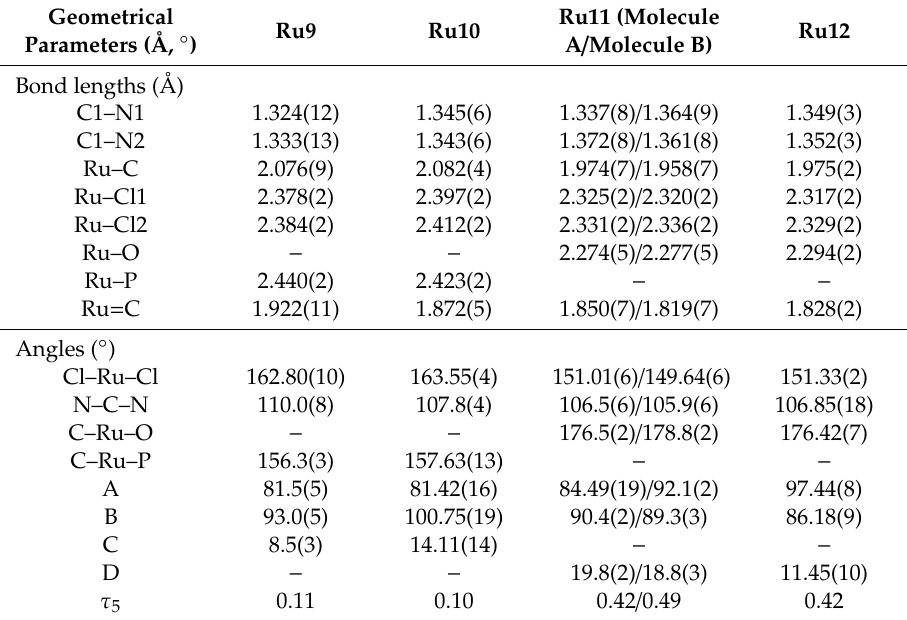
Table 1. Selected geometrical parameters of Ru9 – Ru12